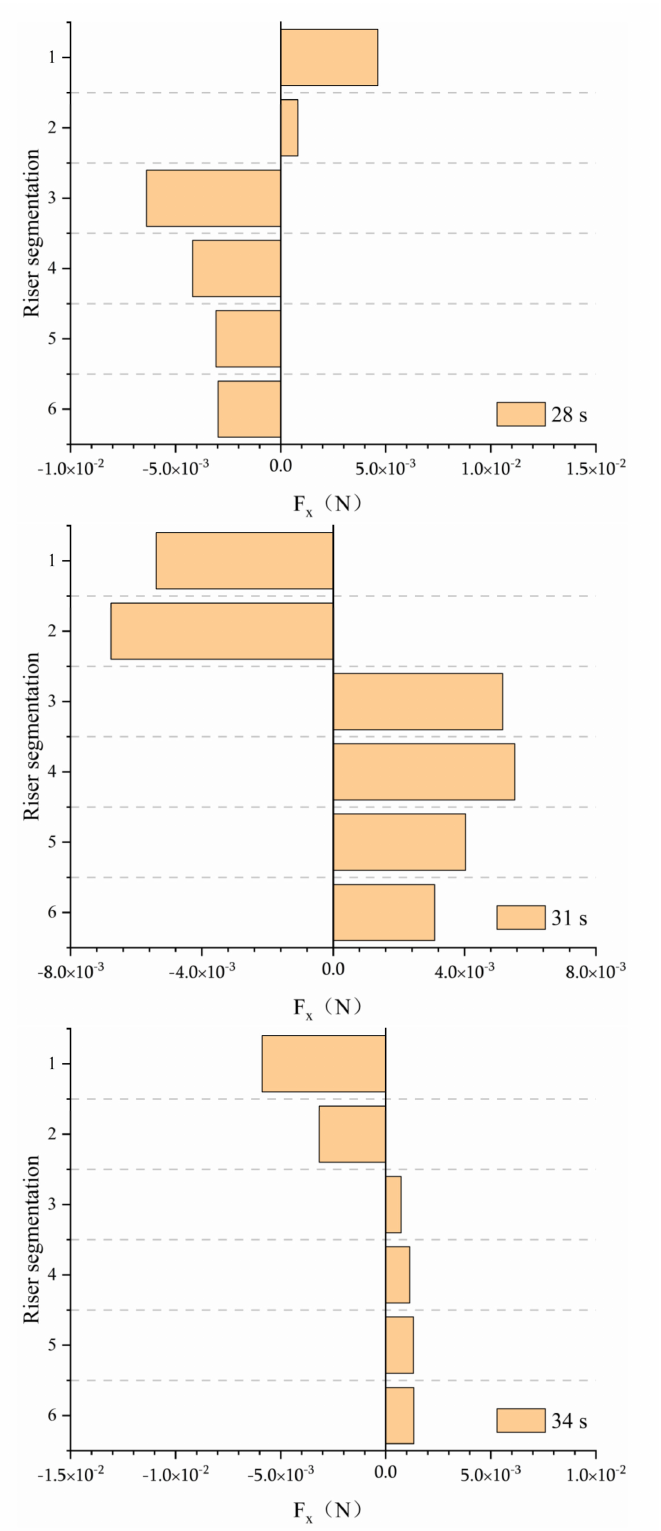
Figure 16. Vertical distribution of force on riser segments at different moments (working condition